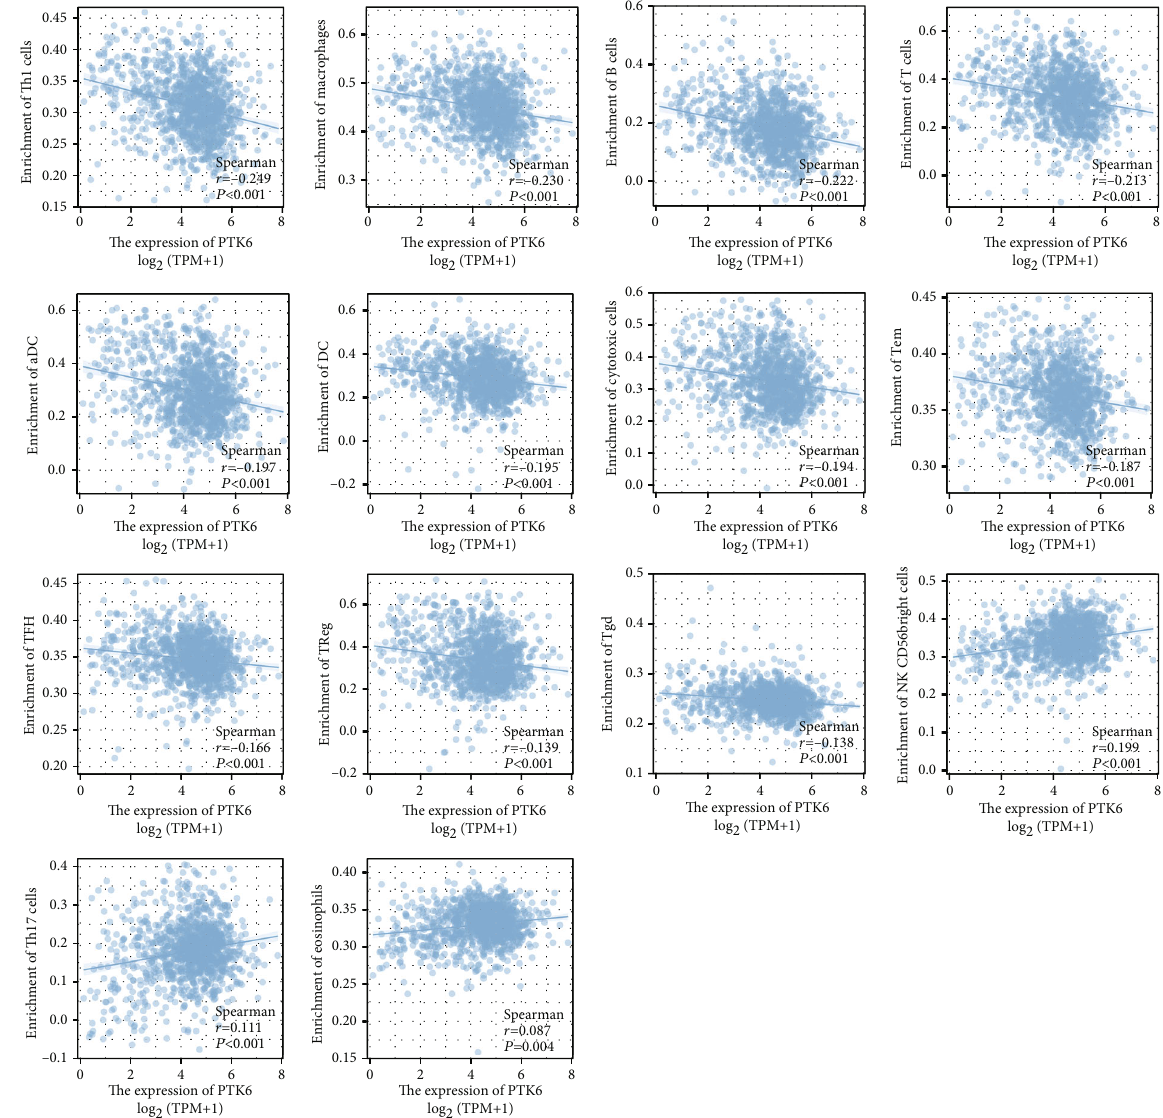
Figure 10: The correlations between the expression of PTK6 and immune cell. PTK6 expression was positively correlated with several immune